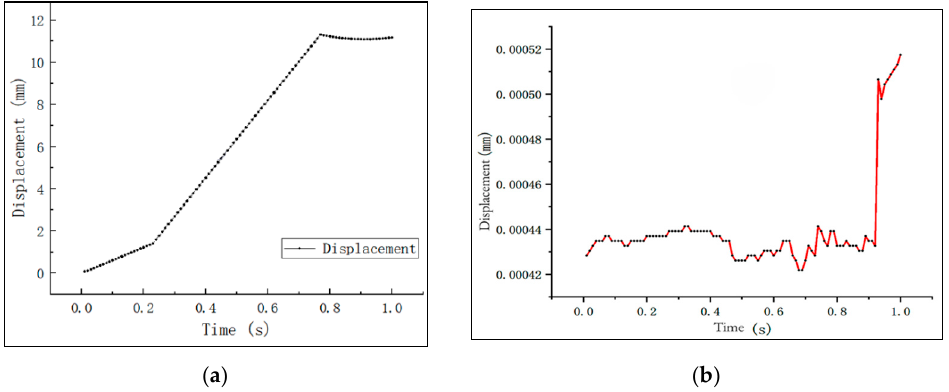
Figure 9. x -axis and y -axis linkage displacement curves. ( a ) the moving displacement of the x and y axis linked with the nozzle head; ( b ) the displacement of the z